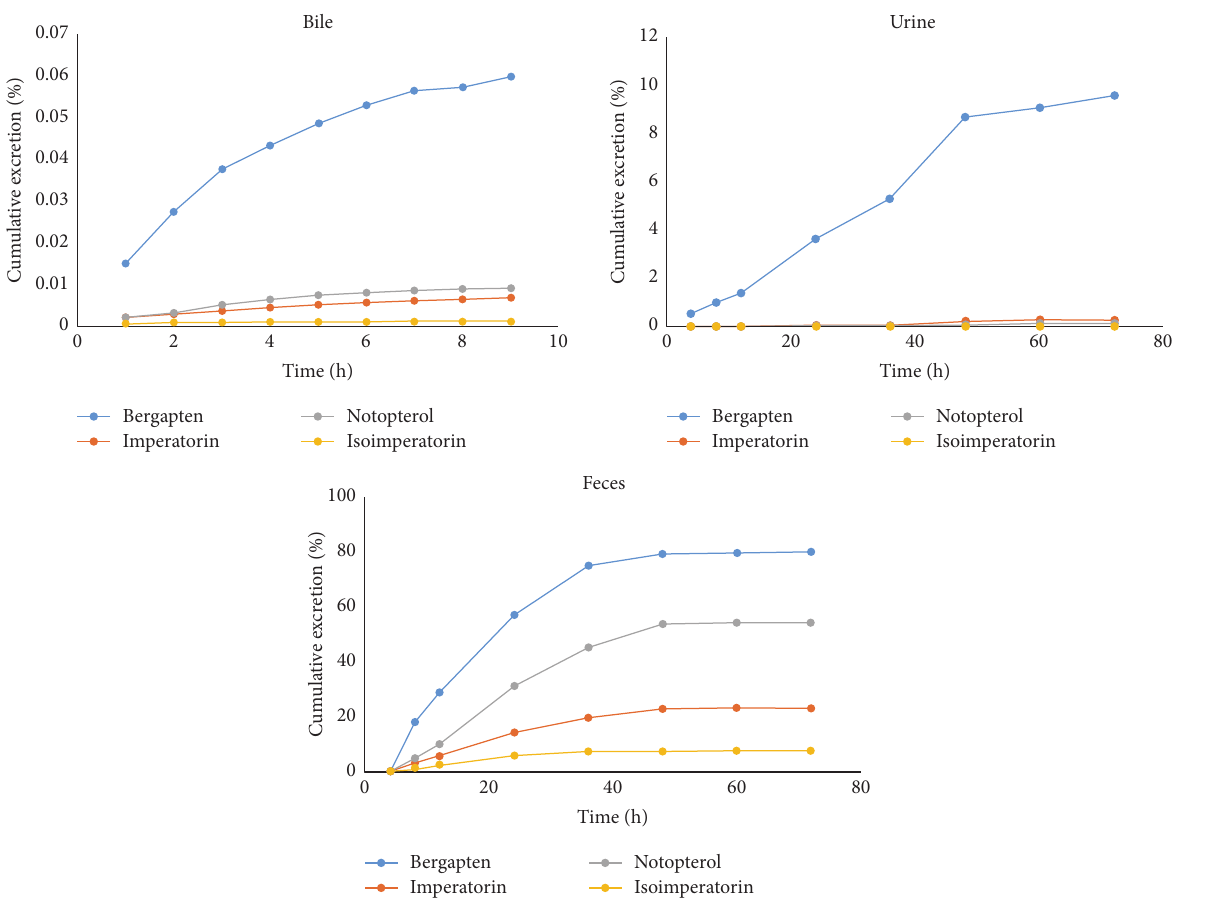
Figure 4: Bile, urinary, and fecal cumulative excretion of the four analytes in rats following oral administration at a dose of 4.2 gkg −1 N. incisum